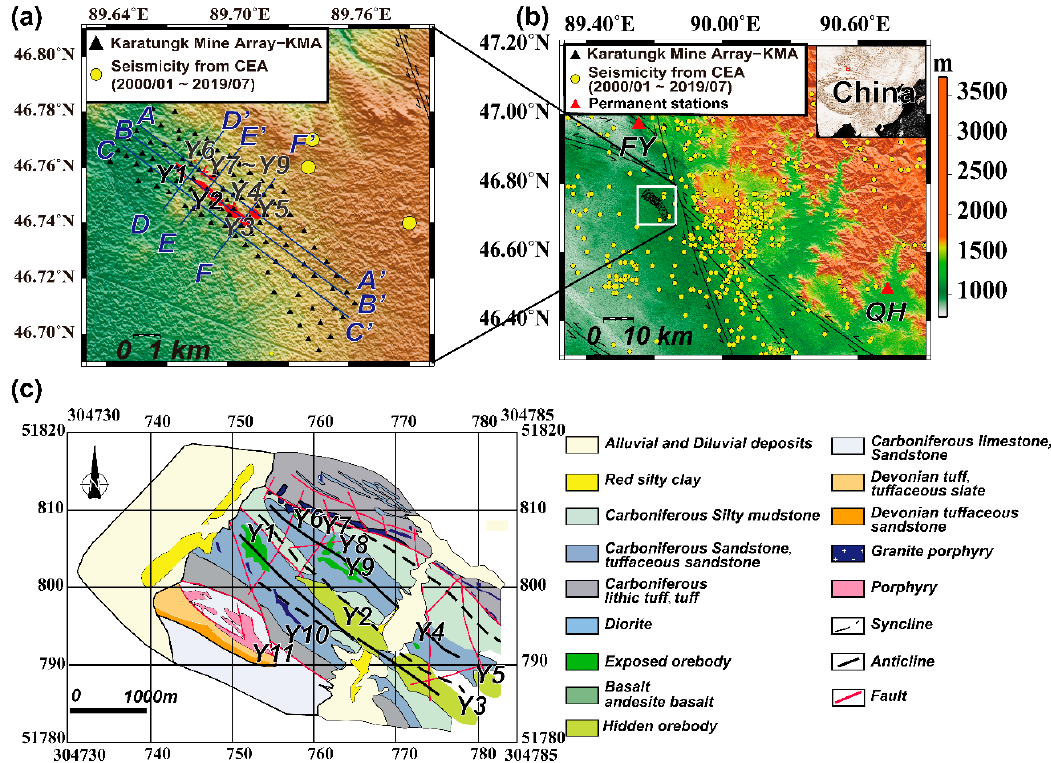
Figure 1. Karatungk Mine, local geological setting, and seismic array. ( a ) Topographic map and the Karatungk Mine array—KMA. The map shows the location of KMA (black triangles). Blue solid lines show the profiles across the mine on which velocity model is presented. Red areas represent the ore-hosting intrusions. White letters are the name of intrusions. ( b ) The regional map of Karatungk Mine: black lines are faults and red triangles show the permanent stations in Xinjiang Province, yellow circles show the seismicity from China Earthquake Network Center. The inset shows the geographic location of this map. The white rectangle shows the geographic location of ( a ). ( c ) Detailed distribution of ore-hosting intrusions (Y1–Y11) in Karatungk Mine, modified from [5]. Labels of horizontal and vertical axis are the location of the mine given in Geodetic coordinate system. Right panel shows detailed structural attributes.